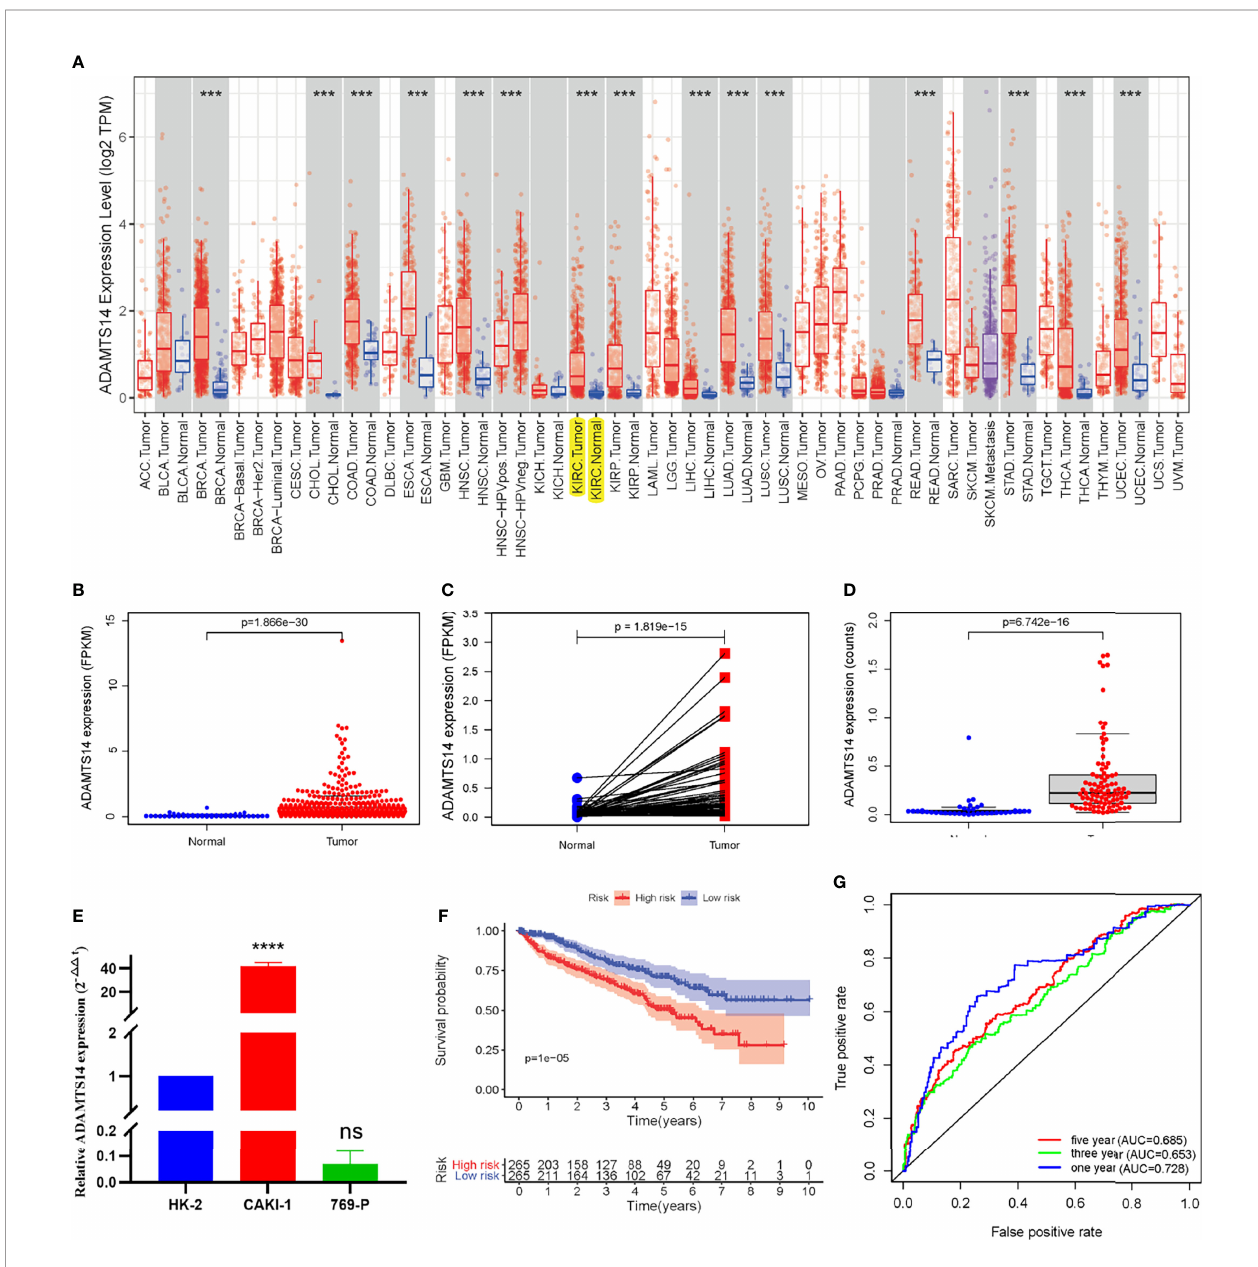
FIGURE 1 | The ADAMTS14 mRNA expression levels in ccRCC. (A) The mRNA expression levels of ADAMTS14 in pan-Cancer from TCGA datasets. (B) Boxplot of the ADAMTS14 mRNA expression (FPKM) in TCGA ccRCC dataset ( T = 539, N = 72). (C) Pairwise boxplot of the ADAMTS14 mRNA expression (FPKM) in TCGA ccRCC dataset ( T = 72, N = 72). (D) Boxplot of the ADAMTS14 mRNA expression (counts) in the ICGC dataset ( T = 91, N = 45). (E) qRT-PCR results of ADAMTS14 detected from ccRCC cells (2 - DD Ct method). (F) Kaplan – Meier survival curve of ADAMTS14 in TCGA ccRCC dataset. (G) ROC curves associated with 1-, 3-, and 5-year AUC values of ADAMTS14 in TCGA ccRCC dataset. *** P < 0.001; **** P < 0.0001; ns, not signi fi